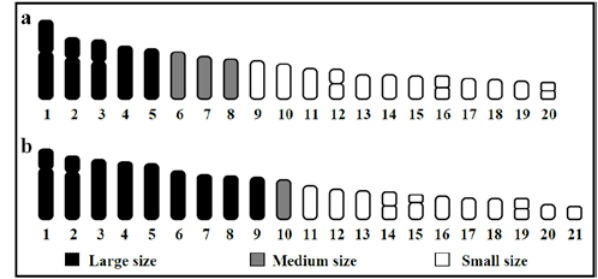
Fig. 3. Standardized idiogram of Cyrtodactylus kunyai (a) and C. interdigitalis (b) by conventional